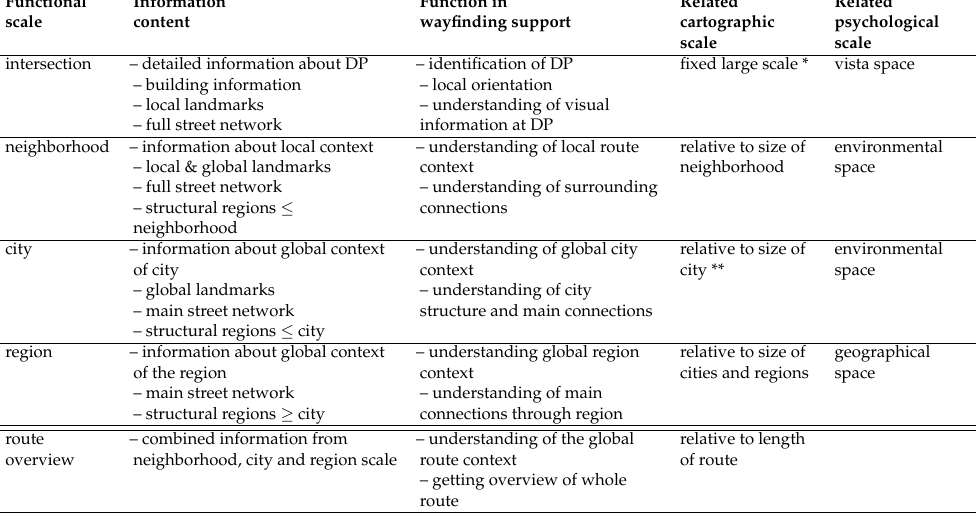
Table 1: Functional scales in wayfinding support (reproduced from Löwen et al.